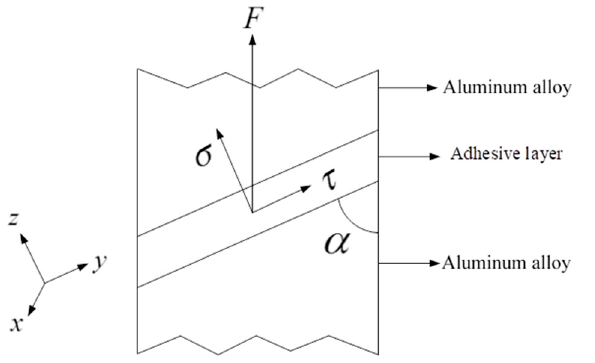
Figure 1. Orientation of stress vectors within adhesive of scarf joints.